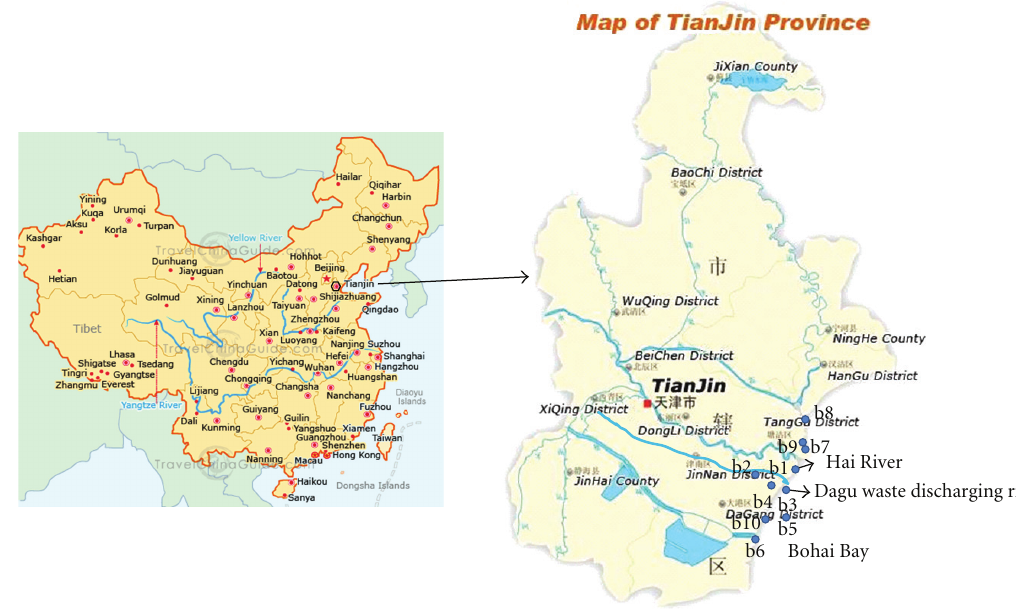
F 1: Plot of sediment sampling locations in Tianjin coastal area. b1: mouth of Hai River; b2: Dagu waste discharge river; b3: mouth of Dagu waste discharge river; b4: offshore river; b5: Du waste discharging river; b6: Bei waste discharging river; b7: offshore sea; b8: Yinghe reservoir; b9: mouth of yongding new river; b10: Beitang waste discharging